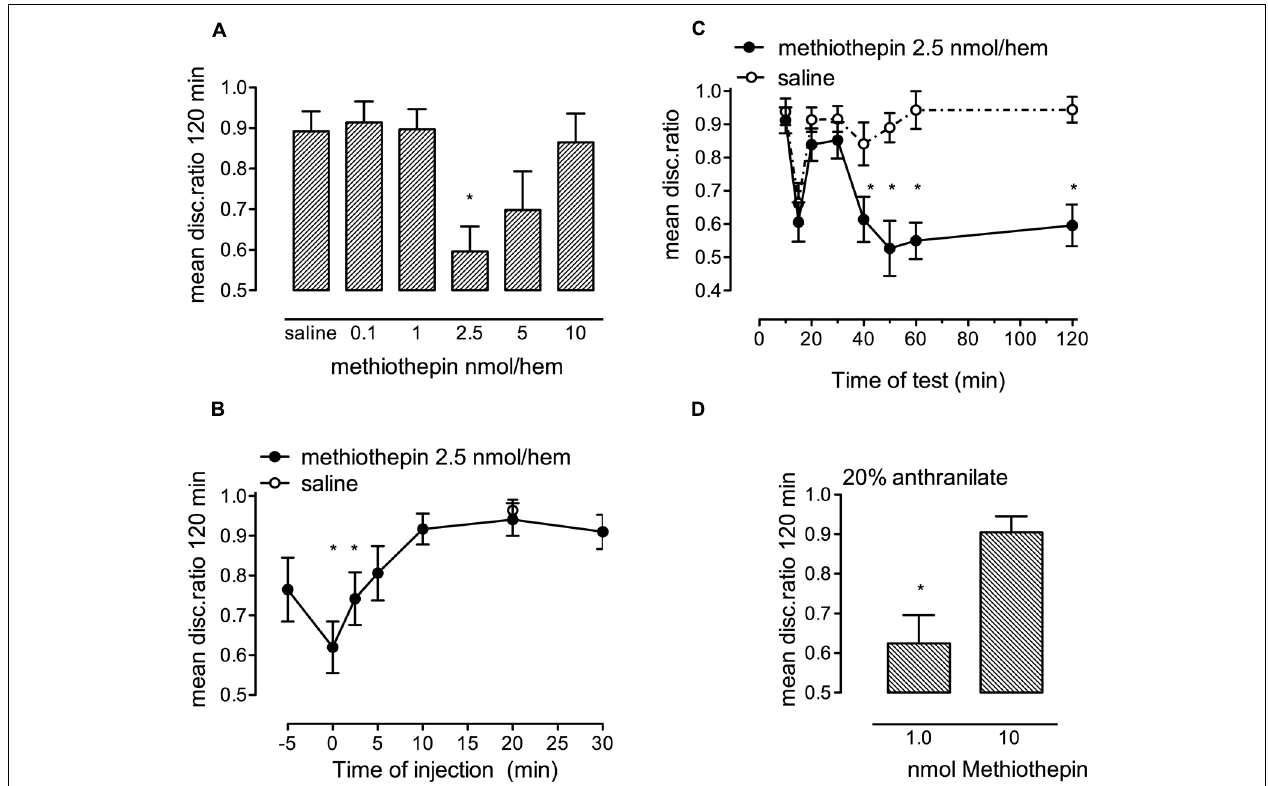
n = 13–18 per group. * P < 0.05. (D) Test of two contrasting doses of methiothepin on memory following 20% anthranilate training, the low dose does not promote consolidation, whereas the discrimination ratio after administration of the high dose indicates normal memory retention, n = 16–18 per group. * statistically significant difference ( P < 0.05) from saline-injected animals.